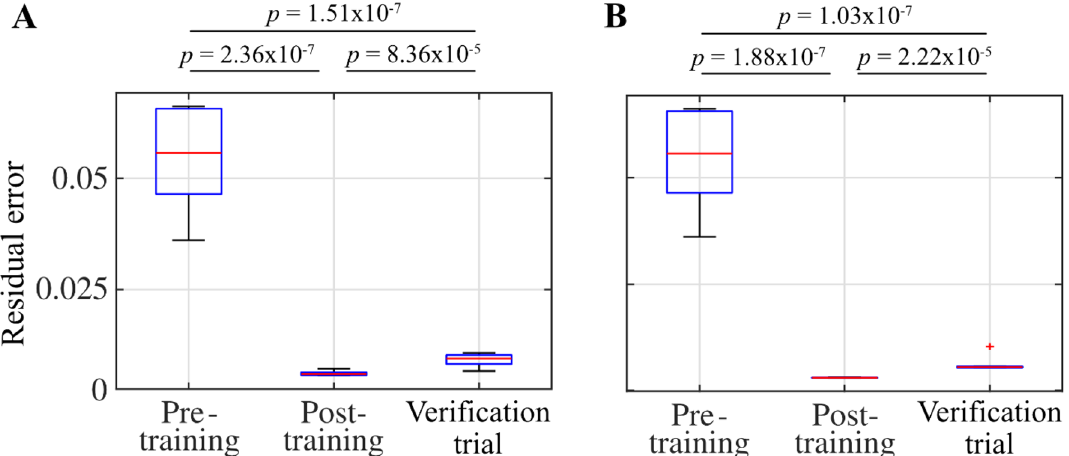
Figure 6. Residual errors. ( A ) and ( B ) show the residual errors (see Eq. (8)) of the models trained by artificial teacher signals and measured muscle activity, respectively. Multiple comparisons with Bonferroni adjustment illustrate significant differences between the residual errors of the pre-training and post-training, and pre- training and verification trials ( p <